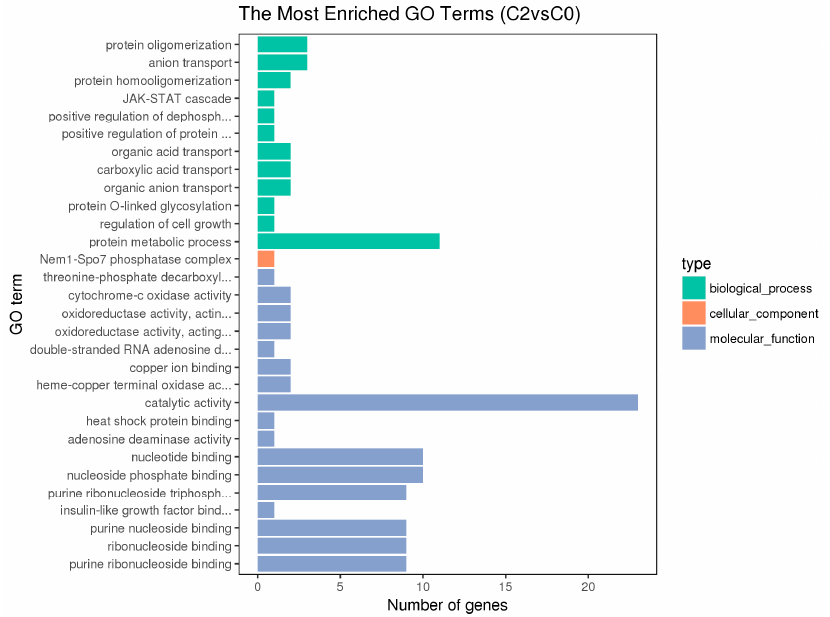
Figure 5. Histogram of GO Enrichment of the Pituitary DEGs.